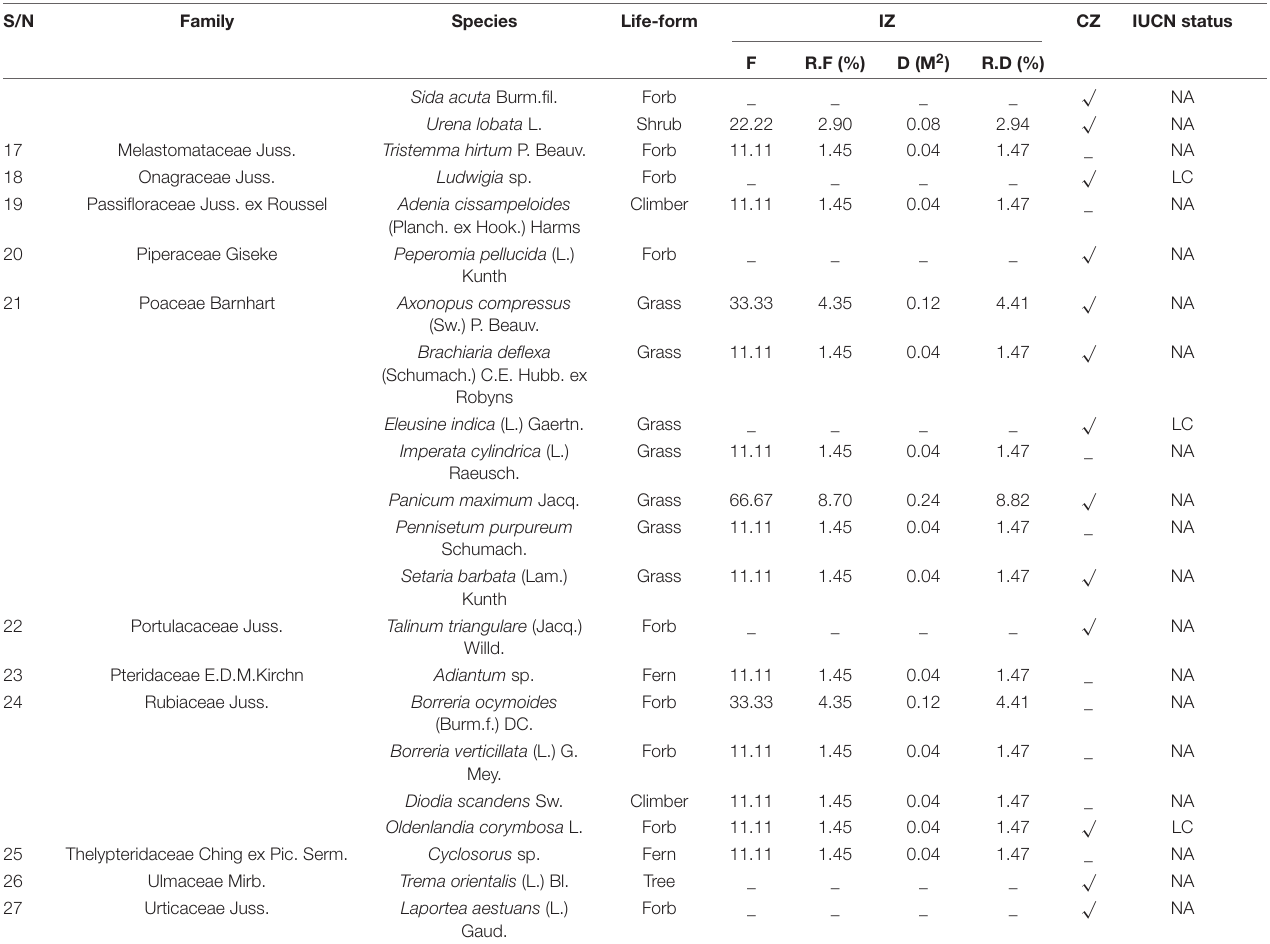
Urticaceae Juss.